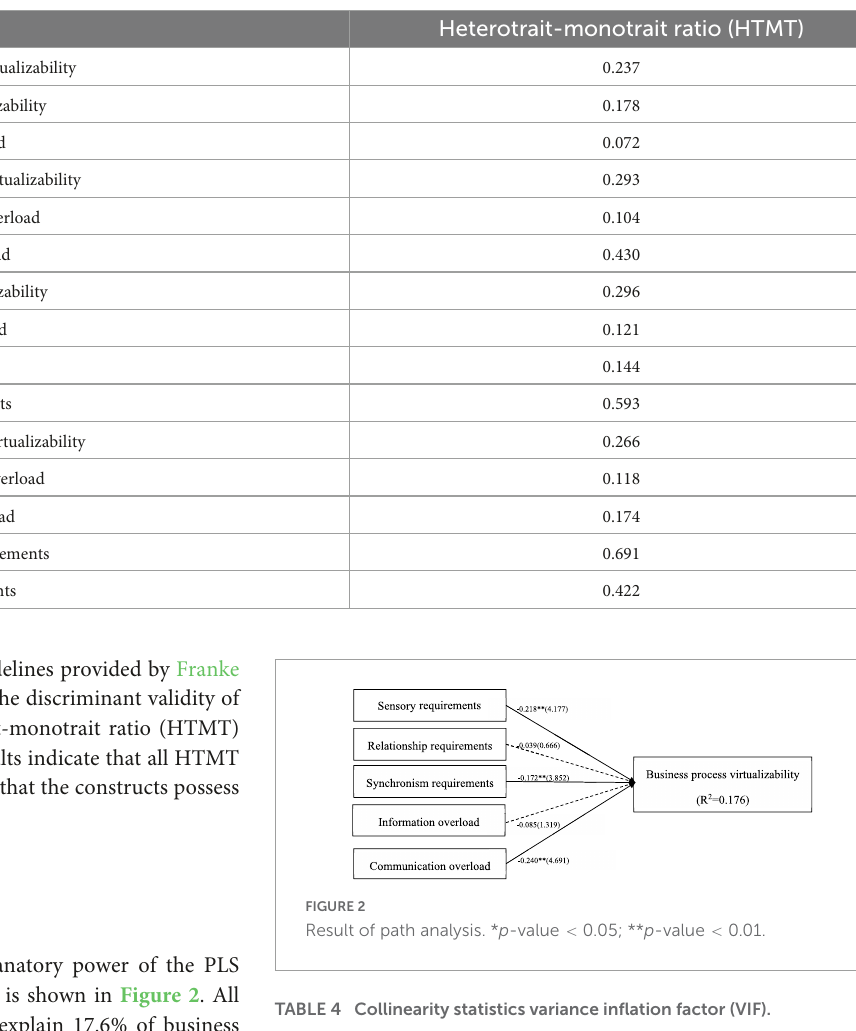
TABLE 3 Discriminant validity.